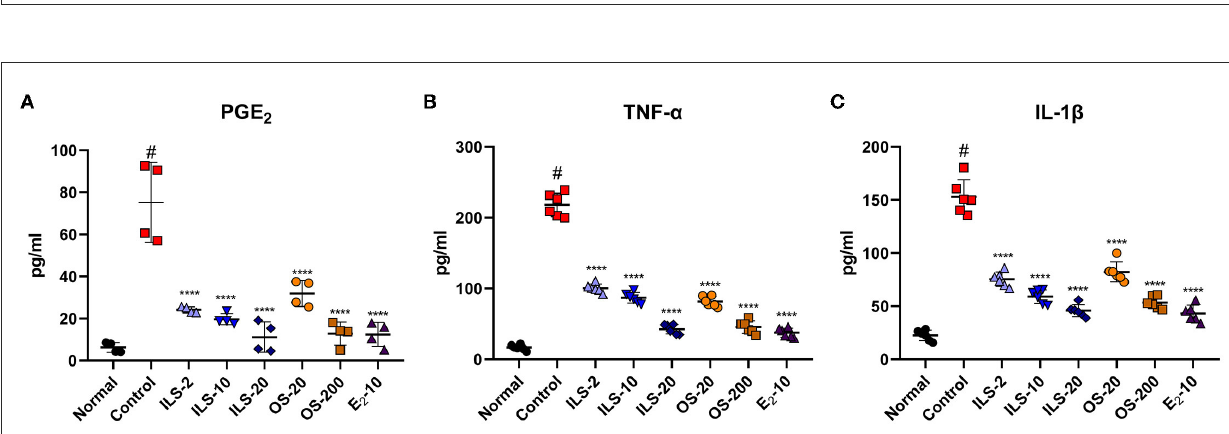
FIGURE2 Effect of Shinbaro 2 on the expression of serum PGE2, IL-1 β , and TNF- α levels in LDH rats. (A–C) ELSA for (A) PGE2, (B) TNF- α , and (C) IL-1 β levels in the serum of each group at 14 days. Data are expressed as the means ± SEM. Significant differences indicated as # a p < 0.001 compared vs. the blank group and ****a p < 0.0001 vs. the control group were analyzed via one-way ANOVA with Tukey’s post-hoc